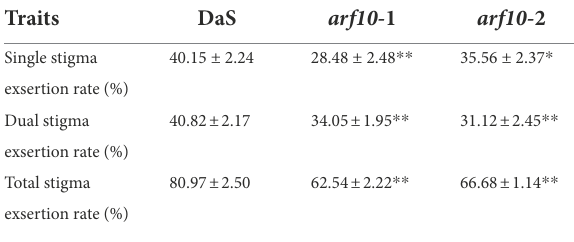
TABLE 3 The stigma exsertion rates of DaS, arf10-1 and arf10-2. Traits